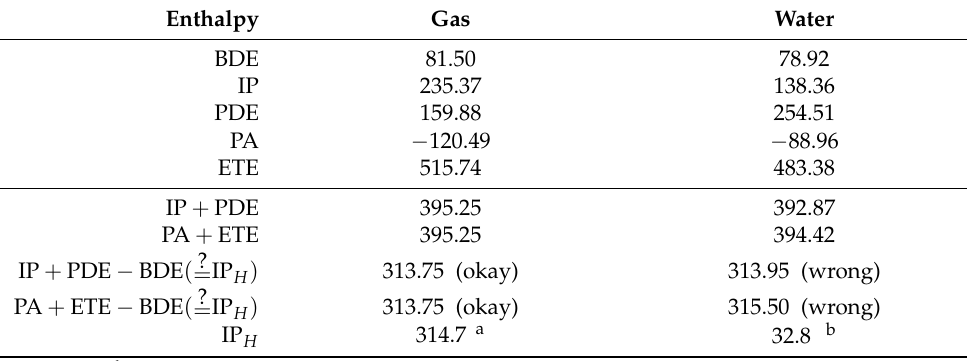
Table 7. The enthalpies of reaction (in kcal/mol) of peonidin according to